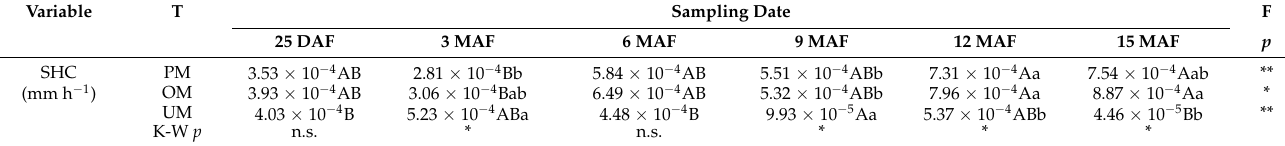
Table 2. Soil hydraulic conductivity (SHC) in the soil in the pine mulch (PM), olive mulch (OM), and unmulched (UM) treatments during the studied period (T, treatments; DAF, days after fire; MAF, months after fire) (mean ± standard deviation). Different letters indicate significant differences between sampling dates (capital letters), and treatment (lowercase letters). Kruskal–Wallis (K-W) (* p < 0.05, ** p < 0.01, and n.s. non-significant at p < 0.05) are shown for each comparison between treatments, and Friedman ANOVA (F) between sampling dates.